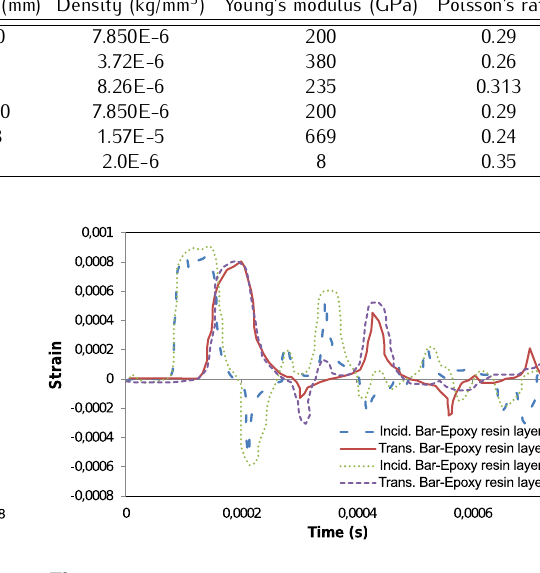
Figure 10. Strain-time curves from incident and transmitted bar. Figure 11. Strain-time curves from incident and transmitted bar.